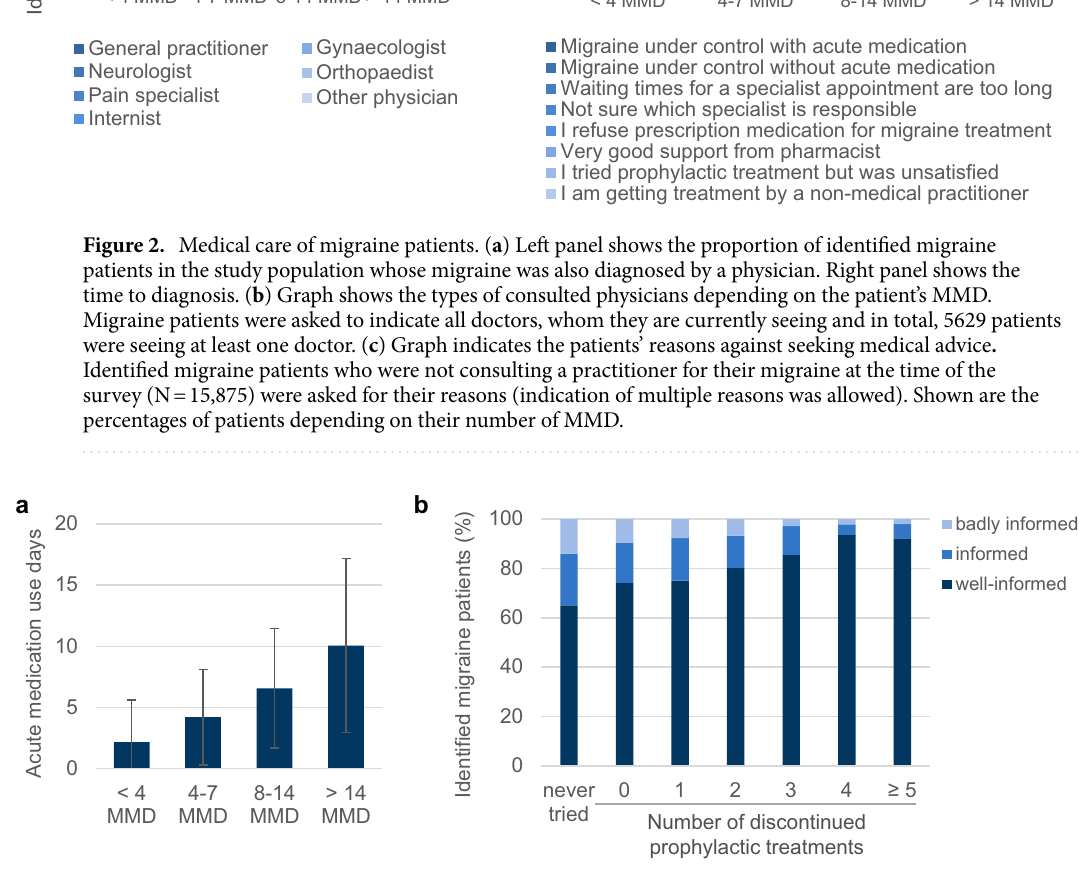
Figure 3. Acute medication use. ( a ) Graph depicts average number of days with acute medication days depending on MMD (mean +/− SD). ( b ) Graph shows the percentage of identified migraine patients that feel well-informed (dark blue), informed (blue), and badly informed (light blue) about medication-overuse depending on the number of discontinued prophylactic treatments. Total patients per group: never tried prophylactic treatment: N = 14,614; 0 discontinued: N = 3460; 1 discontinued: N = 2203; 2 discontinued: N = 657; 3 discontinued: N = 284; 4 discontinued: N = 94; ≥ 5 discontinued: N =